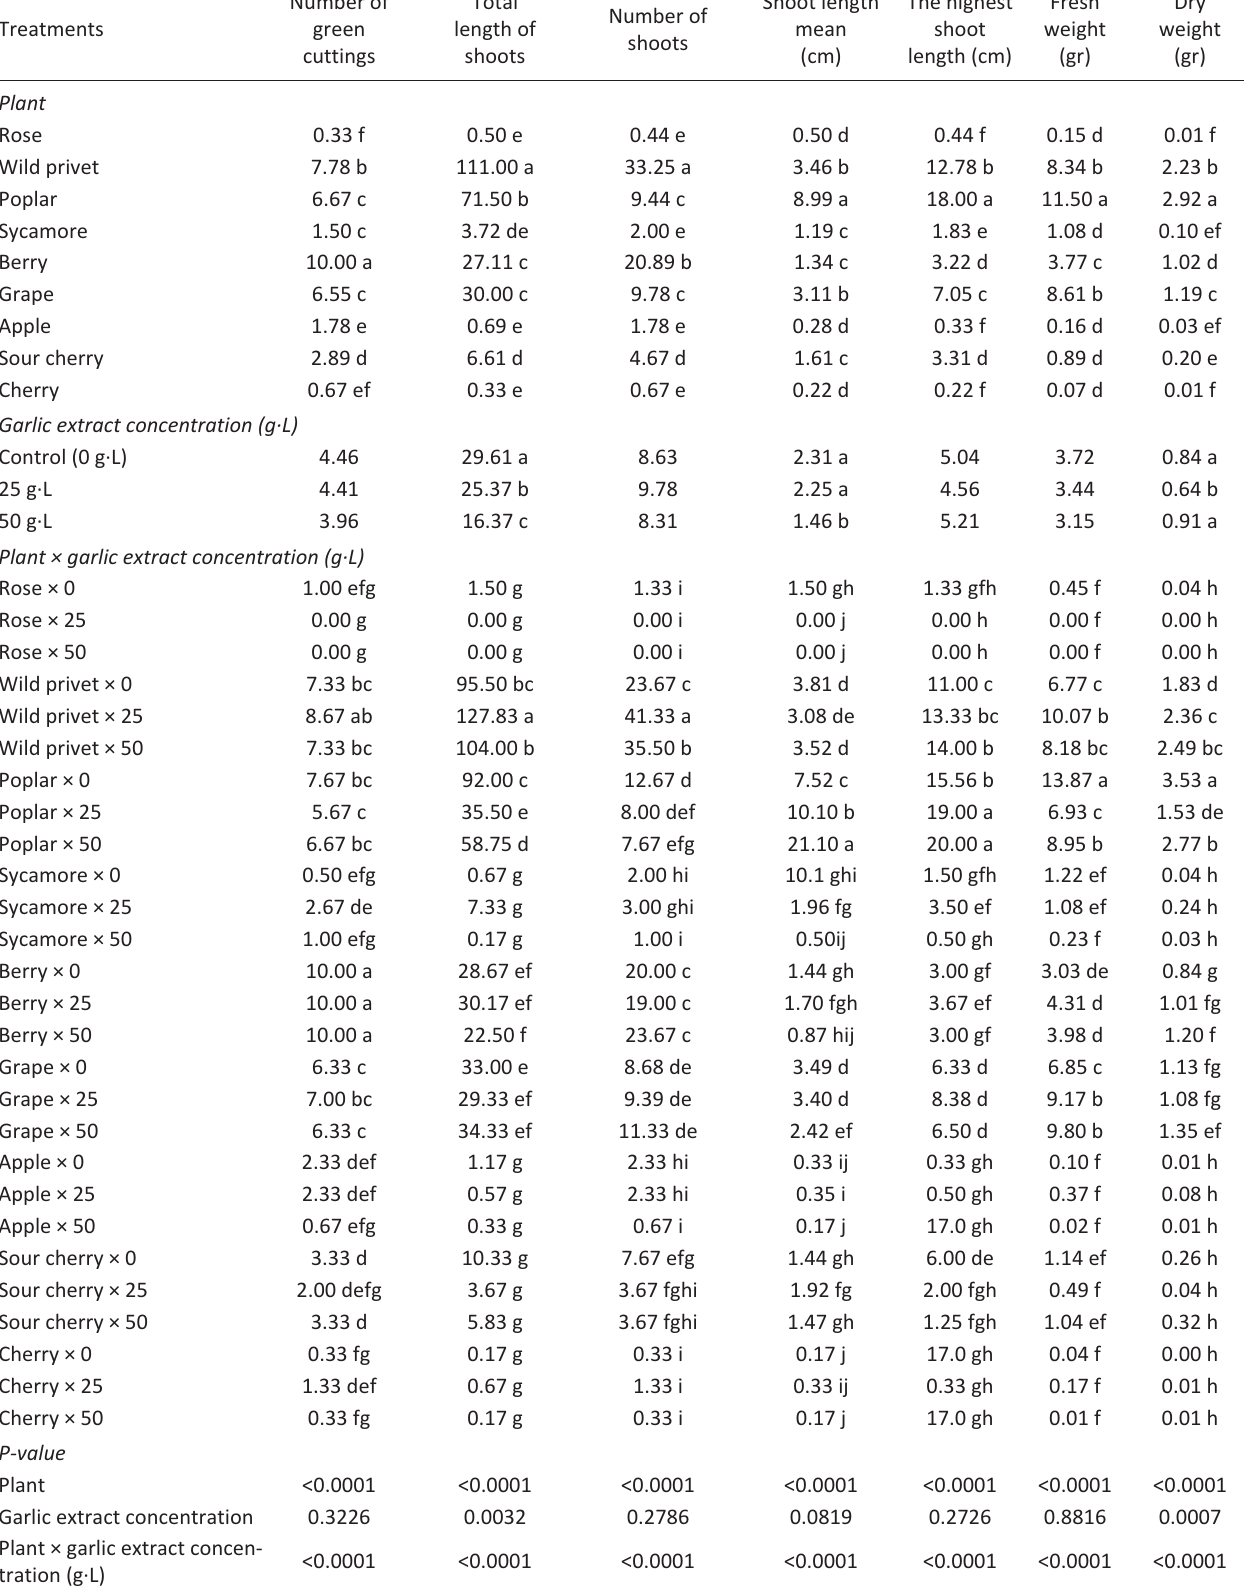
Table 3 ­ Effects of different concentration of garlic extract (on the cuttings) on shoot­related